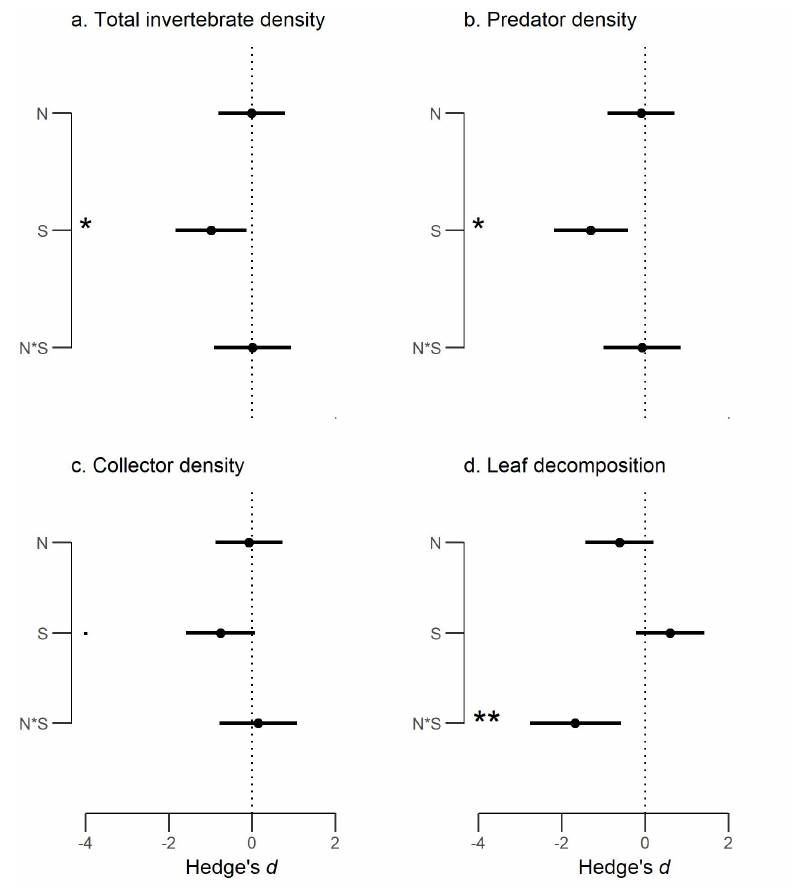
95% CI) for significant main and interactive effects Figure 4. Standardized effect size (Hedge’s d ± of the stressors on first-order channels. Letters are used to represent main effects (N, nutrients; S, sediment) and interactions (N*S, nutrients sediment). For main effects positive values indicate × increases in the response variable, whereas negative values indicate the opposite. For interactions confidence intervals overlapping zero indicate additive interactions, positive values denote synergies, and negative values indicate antagonisms. Symbols are used to represent significance according to the linear models presented in Table 1: ** P < 0.01, * P < 0.05, P < ·